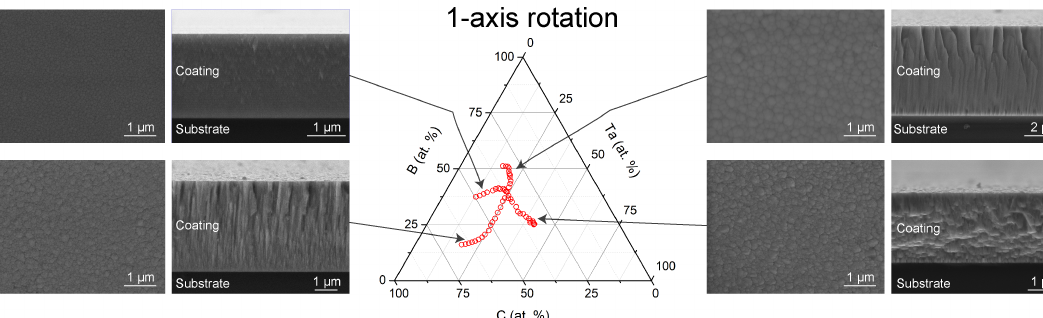
Figure 6. SEM images of surface morphology and unpolished cross-sections of samples performing the 1-axis